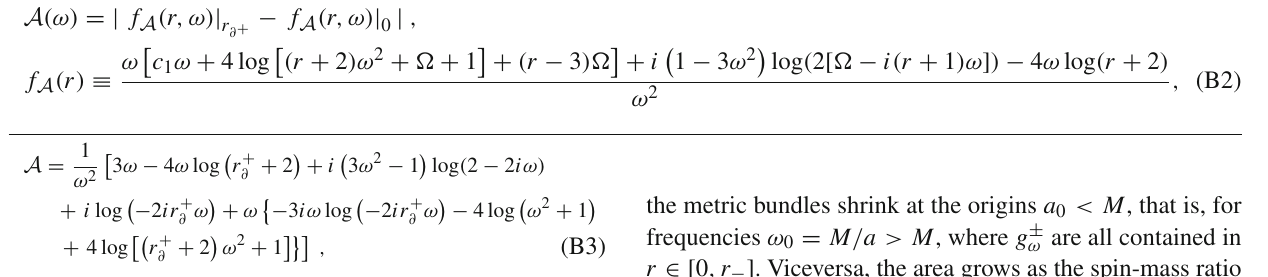
gularities. Solutions of g tt = 0 (black), defining the static limits, and g − 1 rr = 0 (red)definingthehorizons. SeealsoFig.31forthecase Q = 0 (Kerr